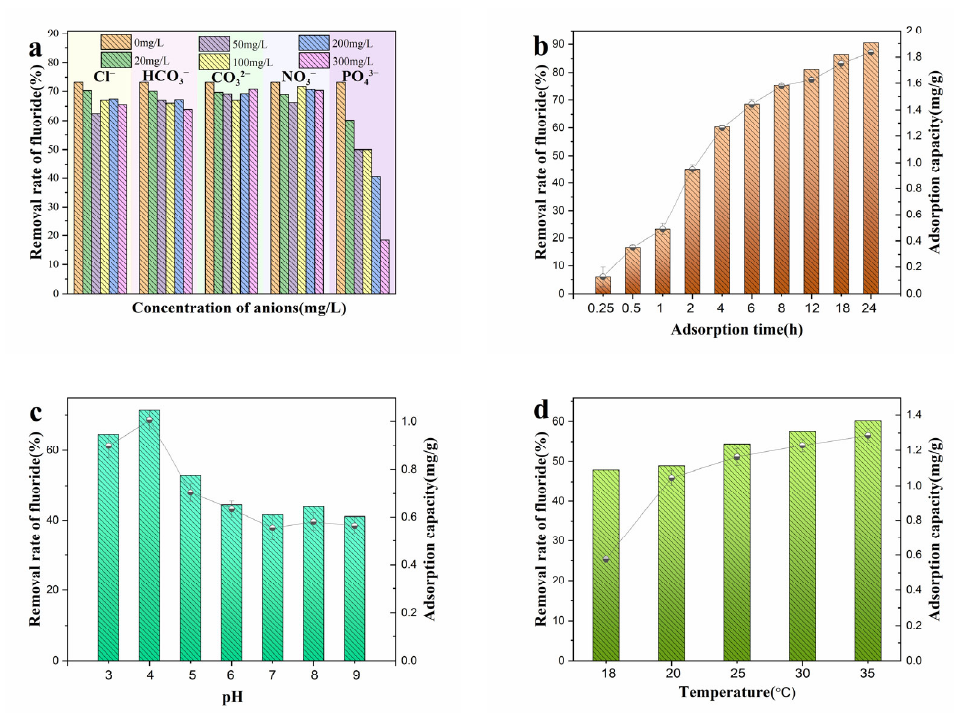
Figure 5. Effect of parameters on removal effect of MAA: competing for co-existing anions ( a ), temperature ( b ), initial pH ( c ), reaction time ( d ).